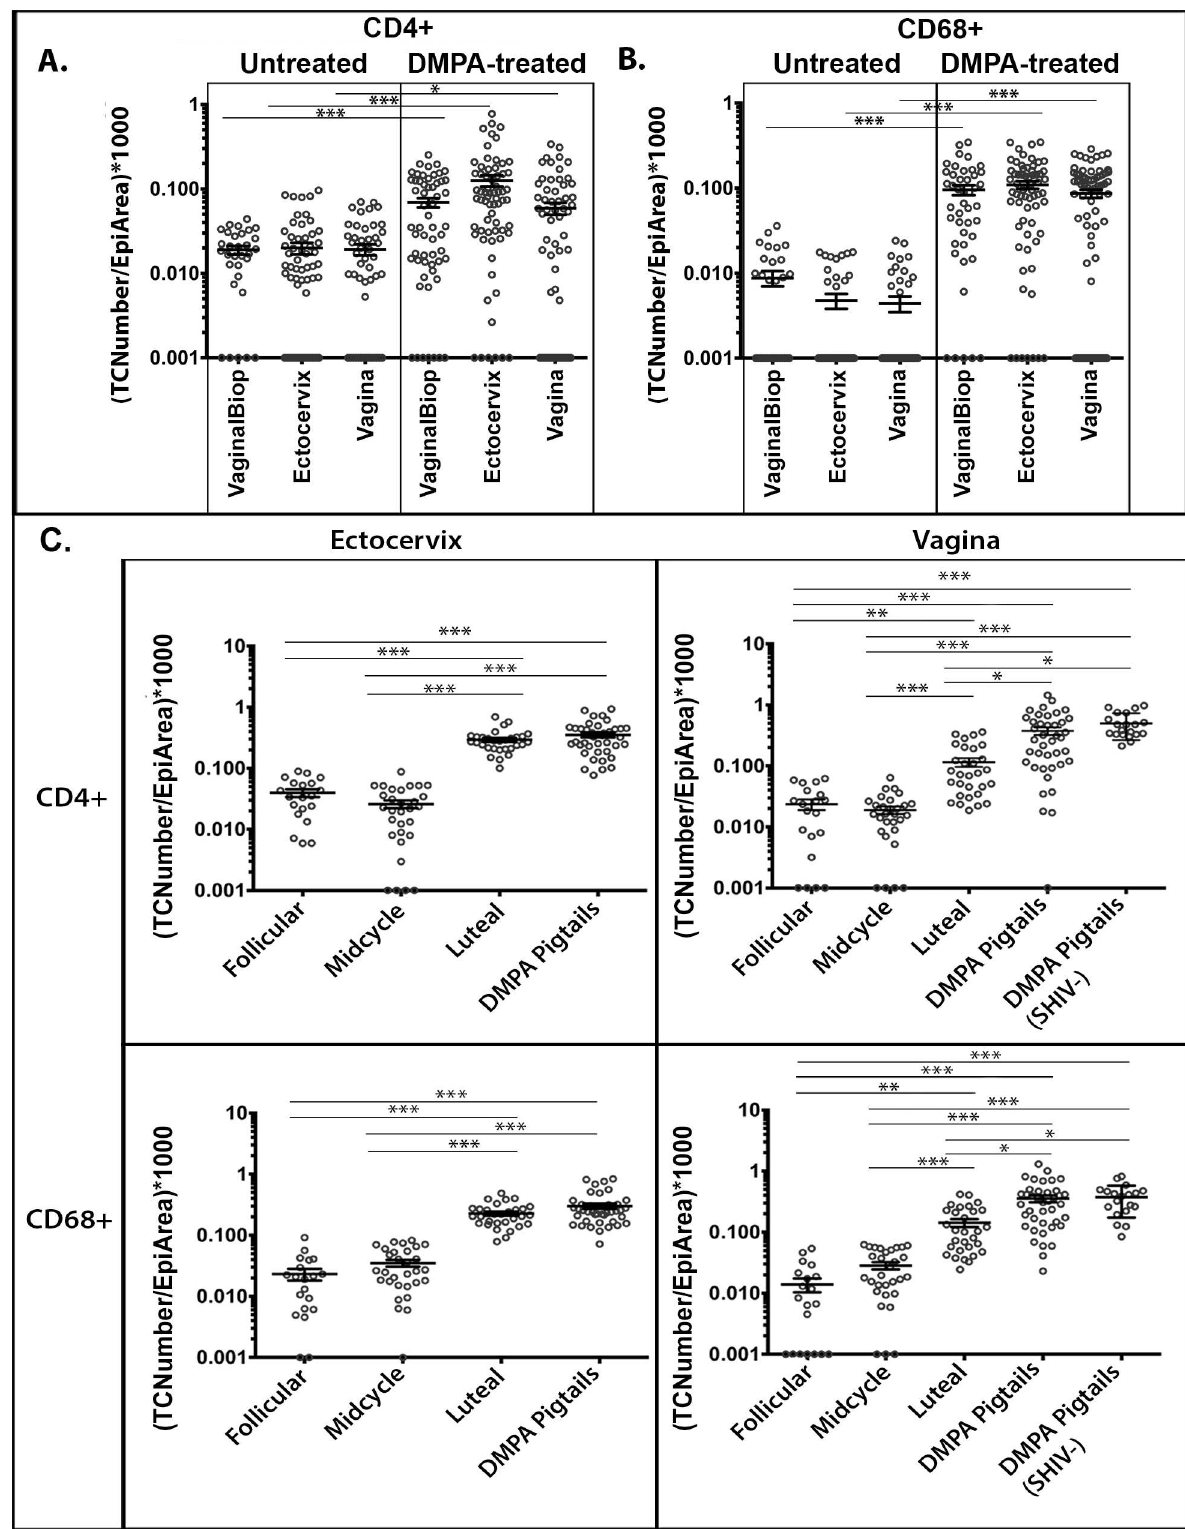
Fig 2. Comparison of Target Cell Densityin Various TissueTypes of Rhesusand PigtailMacaques. Menstrual cycle phases were designated as follicular (day 1 of menstruation until day 14), midcycle(days 14–16),or luteal (days 17 to day priorto